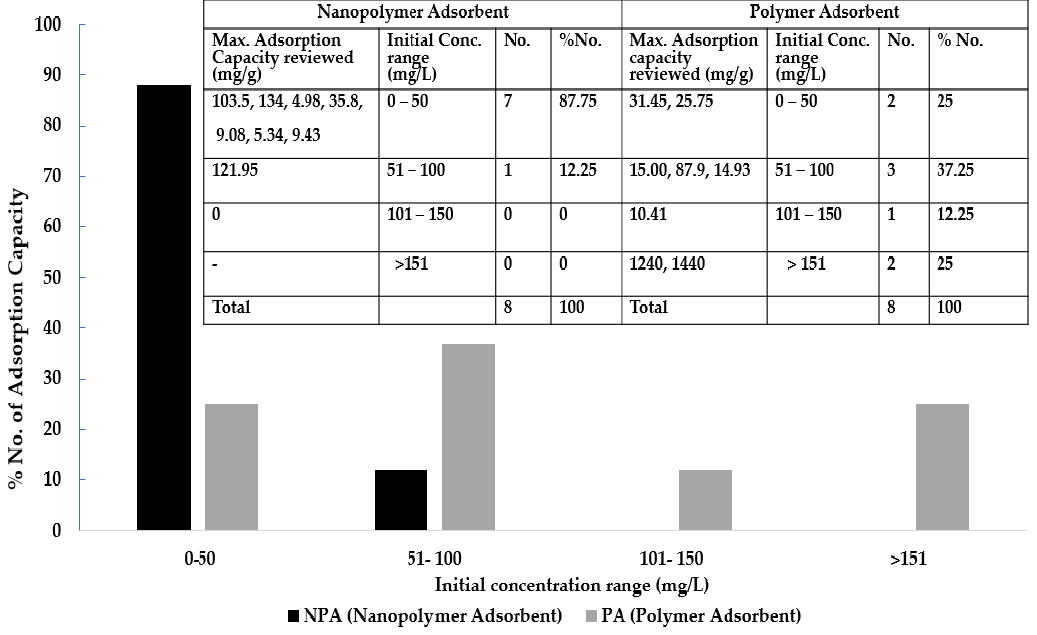
Figure 7. Concentrations with adsorption capacities for polymer and nanopolymer adsorbents.